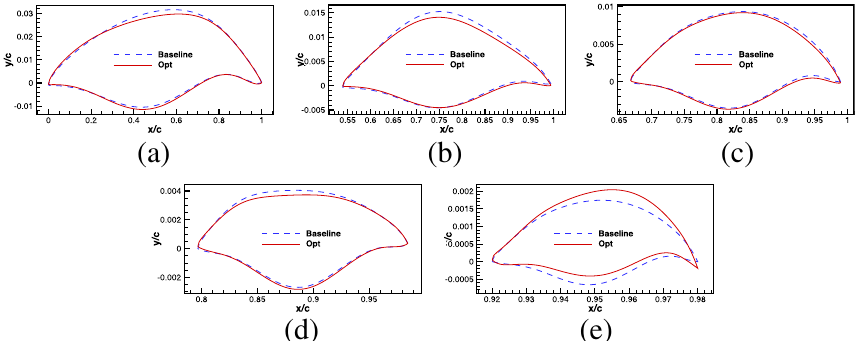
Fig. 26 Comparison of five baseline and optimized wing profiles (optimization case 1). ( a ) Profile 1, ( b ) Profile